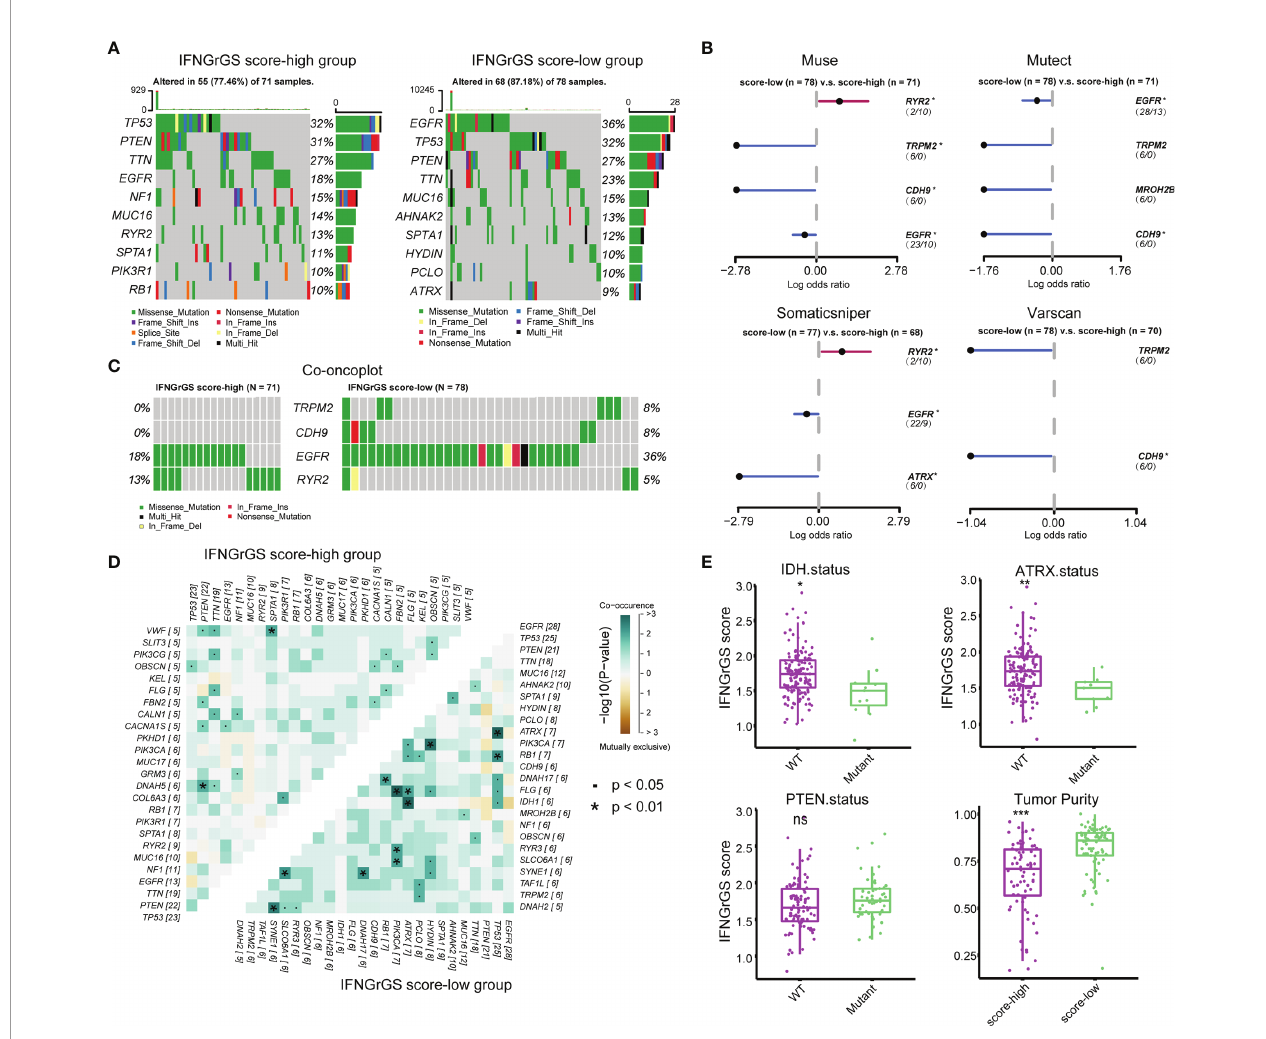
FIGURE 5 | Tumor genomic alterations associated with IFNGrGS-based strati fi cation. (A) The top 10 mutated genes in the IFNGrGS score-high and -low groups based on the somatic mutation fi le ‘ mutect ’ . (B) DMGs in the IFNGrGS score-high and -low groups based on 4 somatic callers using Fisher ’ s exact test. (C) The mutation type and frequency of TRPM2, CDH9, EGFR, and RYR2 based on the ‘ mutect ’ fi le. (D) Co-occurring and mutually exclusive gene pairs. Upper panel: the IFNGrGS score-high group, and lower panel: the IFNGrGS score-low group. (E) The association between the IFNGrGS score and IDH, ATRX, and PTEN gene mutation, and the tumor purity. *p < 0.05, **p < 0.01, ***p < 0.001, and ns, non-signi fi